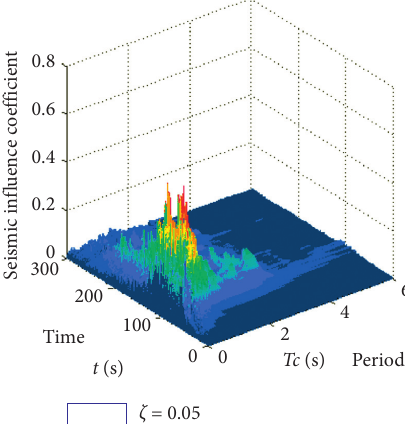
Figure 7: Time-domain absolute acceleration elastoplastic influ- ence coefficient surface (time interval 0.01